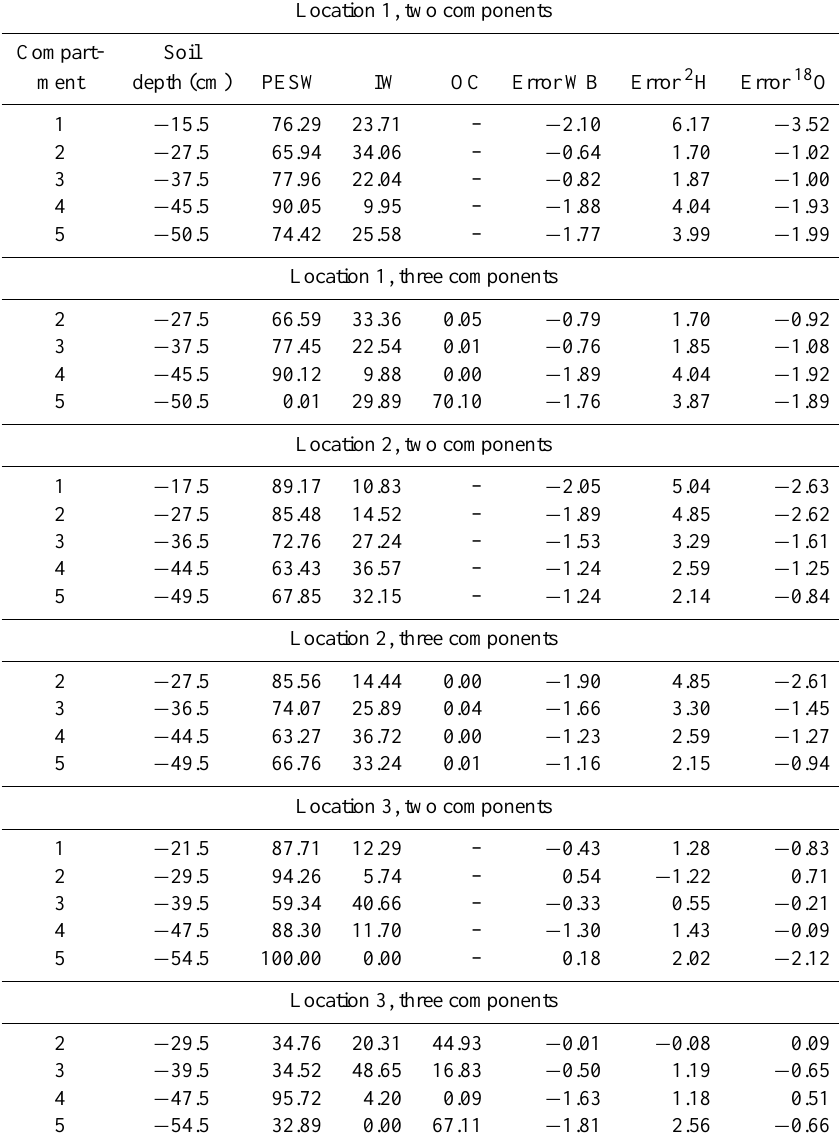
Table 4. Results of the compartmental-mixing modeling performed for every location, and for the two and three end-member modeling. Soil depth is the center depth of a soil compartment (cm), PESW is the proportion of pre-event soil matrix water in the soil compartment (%), IW is the proportion of irrigation water in the soil compartment (%), OC is the proportion of water from the overlying cell (%), Error WB the error in the water balance (%), Error 2 H is the error in the mass balance of deuterium (%), and Error 18 O is the error in the mass balance of oxygen-18